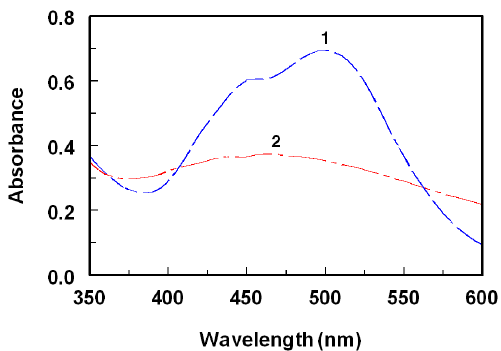
Figure 5. Absorption spectra of the CT complexes of ROS-Ca with bromanil (1) and chloranil (2). Concentrations of ROS-Ca were 80, and 150 μ g mL − 1 in case of bromanil and chloranil, respectively. Solutions were prepared in acetonitrile for reaction with both